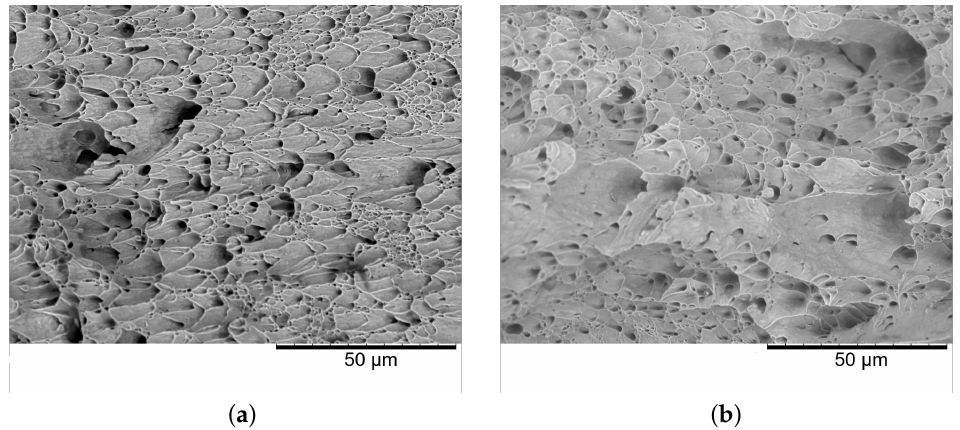
Figure 6. Fracture surface SEM images of the 1000 s − 1 tested specimen magnified 1500 × . Region close to the section edge ( a ). Central region of the section ( b ).